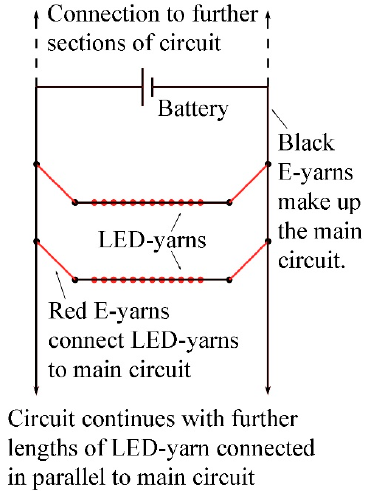
Figure 3. Diagram showing part of the circuitry attached to the costume: LED-yarns, each containing 12 LEDs attached in parallel between black E-yarns that form the main circuit on the costume. Red E-yarns connect the LED-yarns to this main circuit that is connected to a battery.